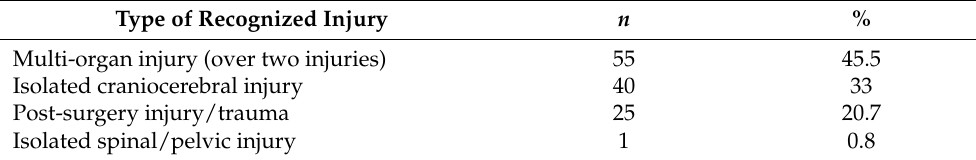
Table 1. Type of injury recognized in a patient upon admission to